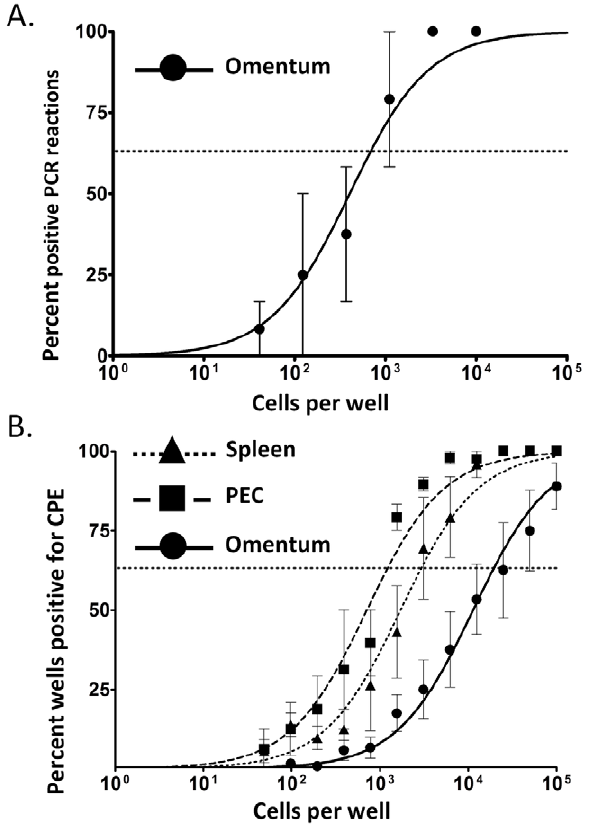
Figure 6. The omentum supports early latent infection. Mice were inoculated i.p. with 1000 pfu virus and PECs, spleen and omenta harvested at day 18 post-infection. Single cell suspensions were used for limiting dilution PCR analyses (omentum) (A) or prepared (see Materials and Methods) and plated immediately for limiting dilution reactivation analyses (spleen, peritoneum, and omentum) (B). A) Frequency of positive PCR reactions after limiting-dilution plating and DNA-quantity controlled PK digest/PCR. B) Frequency of CPE in MEF monolayers after limiting-dilution plating of intact cells as evidence of virus reactivation. Mechanically-disrupted cells were plated in parallel to control for the presence of preformed infectious virus (data not shown).